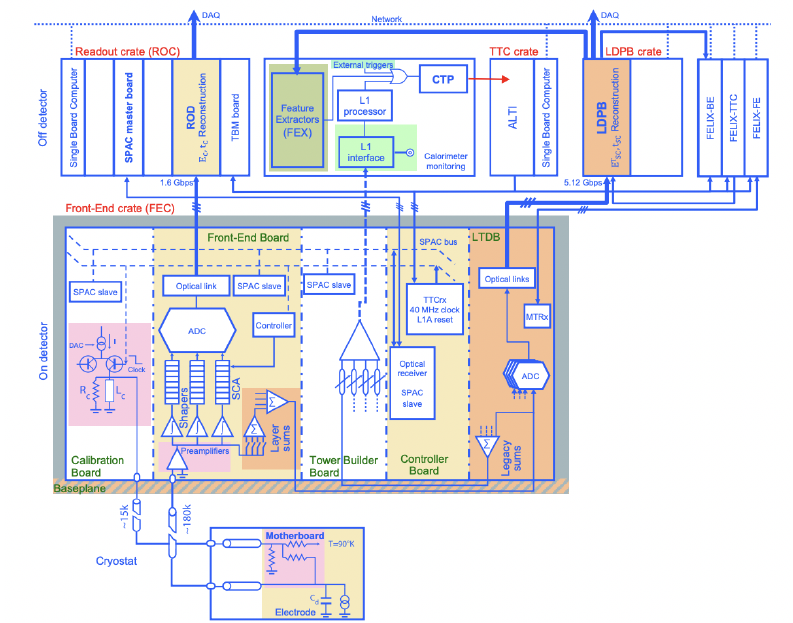
Figure 5. The ATLAS LAr calorimeter readout electronics architecture for the LHC Run 3. The new LAr boards are highlighted in orange. This diagram depicts specifically the electronics of the EM calorimeters